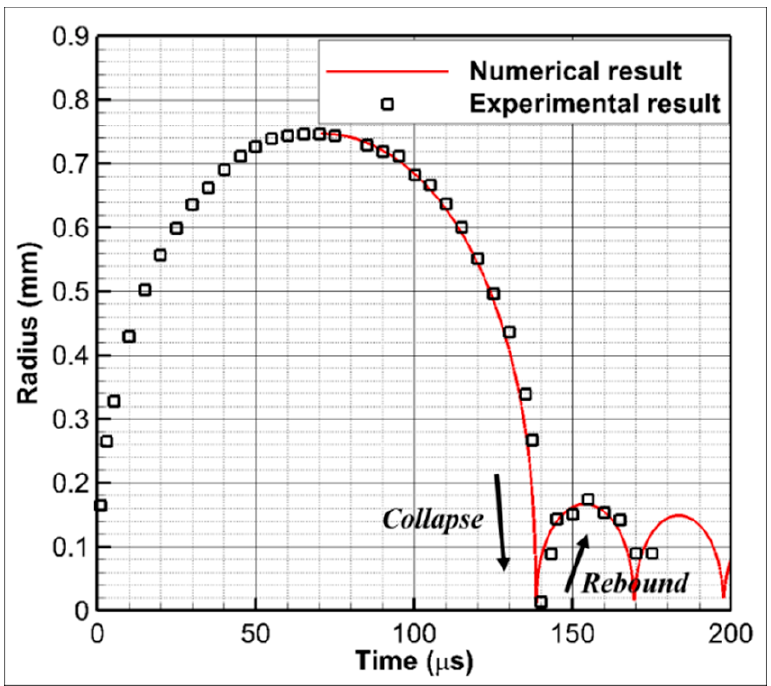
Figure 6. Comparison of numerical bubble radius with experiment.